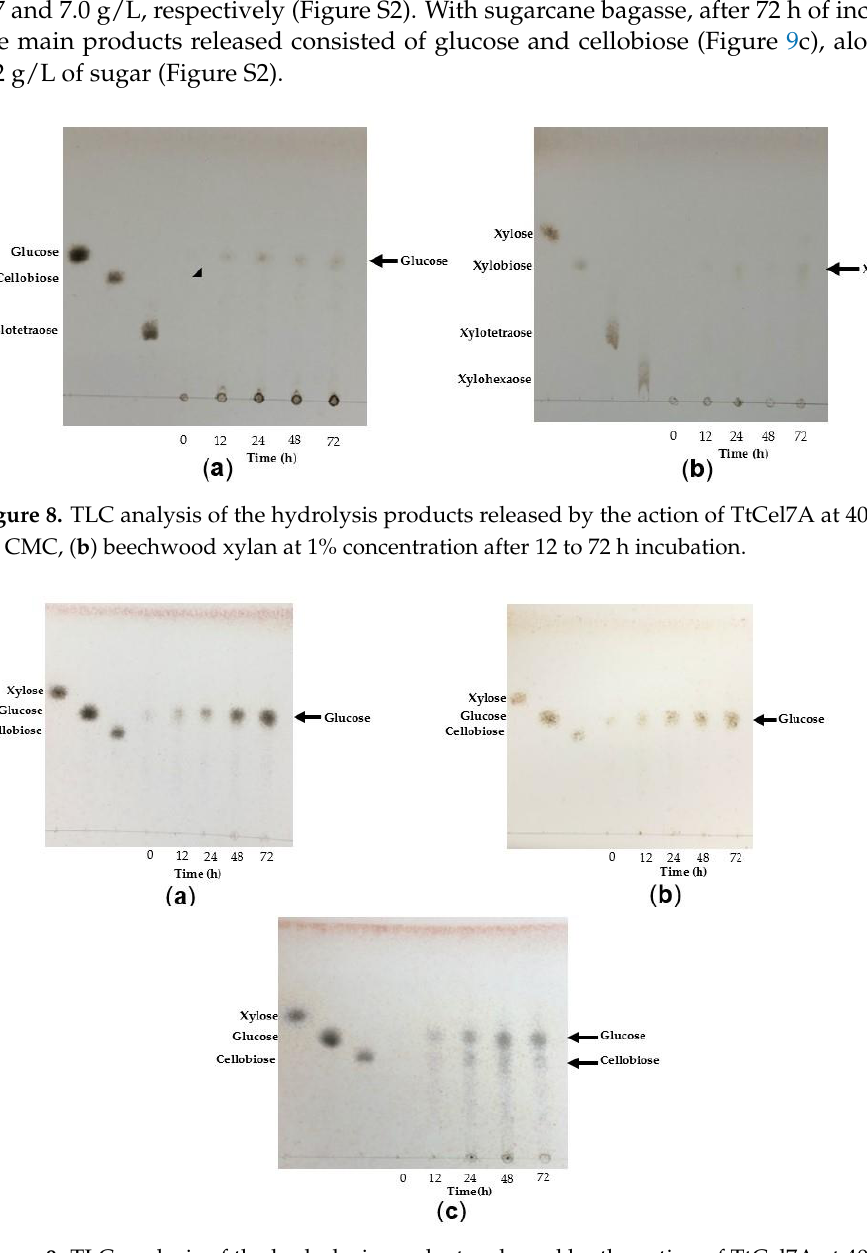
Figure 9. TLC analysis of the hydrolysis products released by the action of TtCel7A at 40 C from ( a ) oat bran, ( b ) wheat bran, and ( c ) sugarcane bagasse at a final concentration of 30 mg/mL.